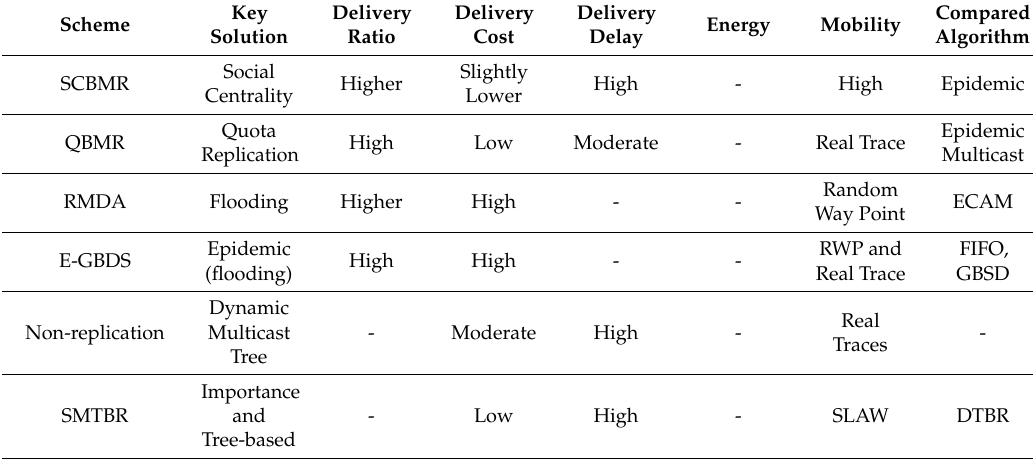
Table 2. Performance comparison of buffer-efficient multicast routing in